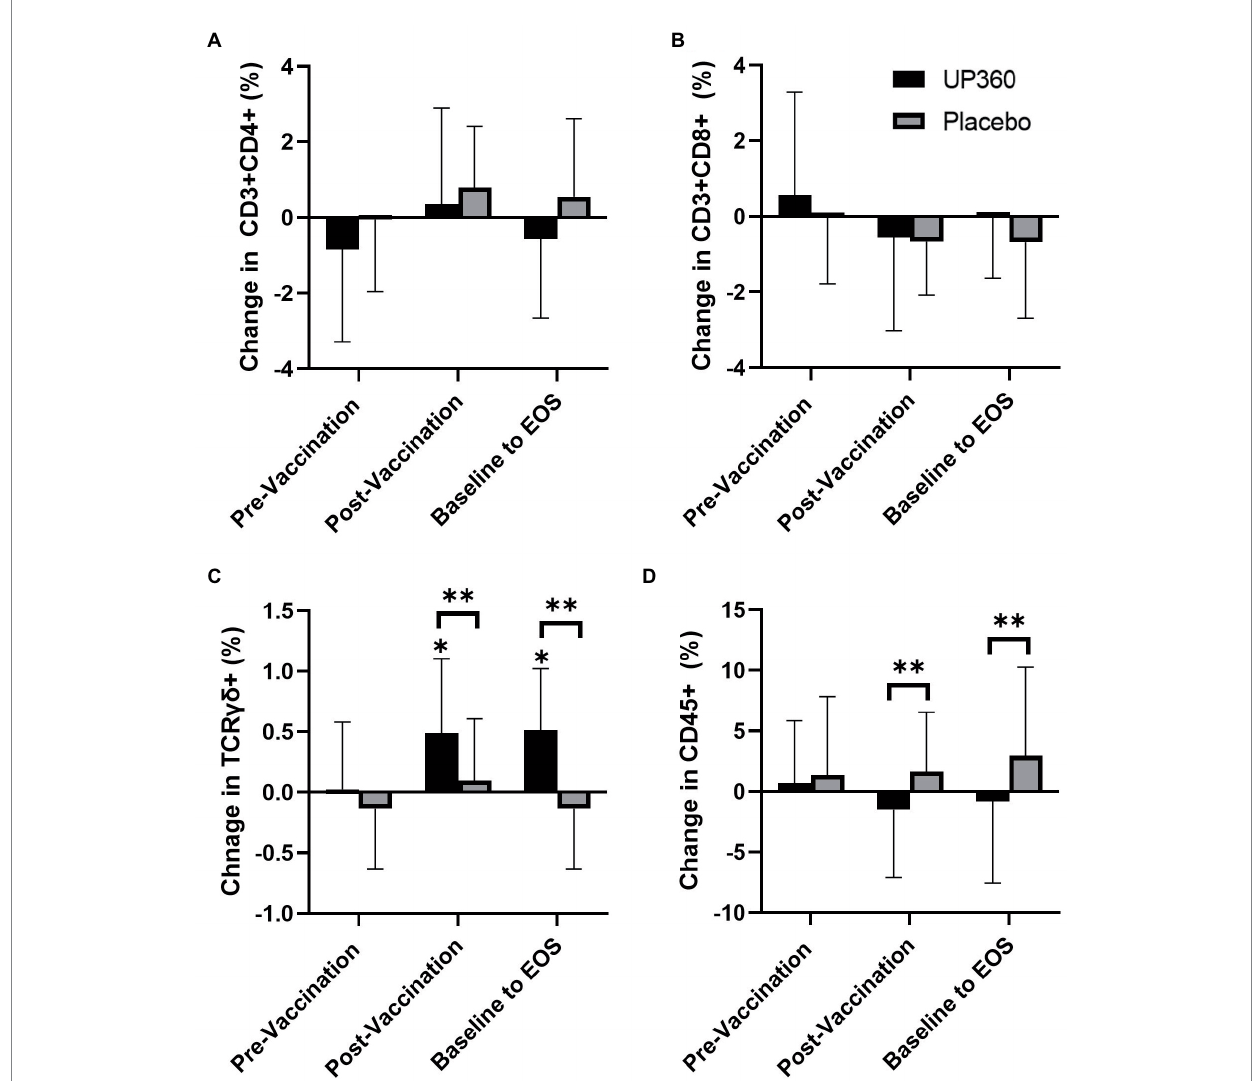
FIGURE 1 Change in the percentage of (A) Helper T cells (CD3 + CD4+), (B) Cytotoxic T Cells (CD3 + CD8+), (C) T-Cell Receptor Gamma Delta Cells (TCR γδ +), and (D) Total Lymphocytes (CD45+) between UP360 and Placebo in the pre-vaccination period (baseline to Day 28), post-vaccination period (Day 28 to Day 56) and from baseline to end-of-study (EOS, Day 56) in the ITT population ( n = 50). Values presented are mean ± standard deviation (SD). *indicates a significant difference within-group at the specified timepoint and **indicates a significant difference